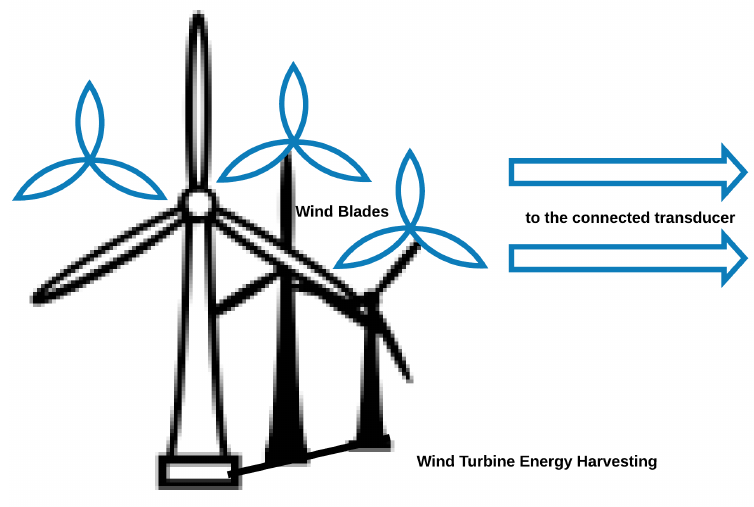
Figure 9. Wind Turbine Energy